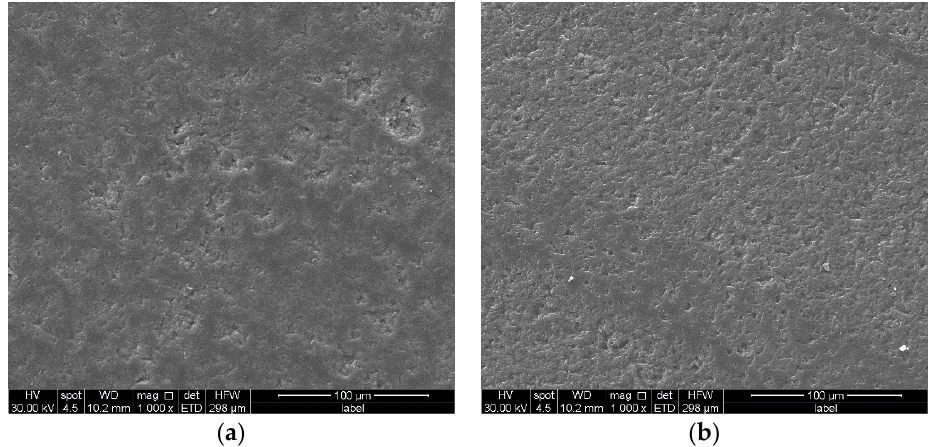
Figure 12. Worn surfaces of the SN0 pin against the PEEK disc in artificial seawater at the following different speeds: ( a ) 0.52 m/s; ( b ) 1.73 m/s.